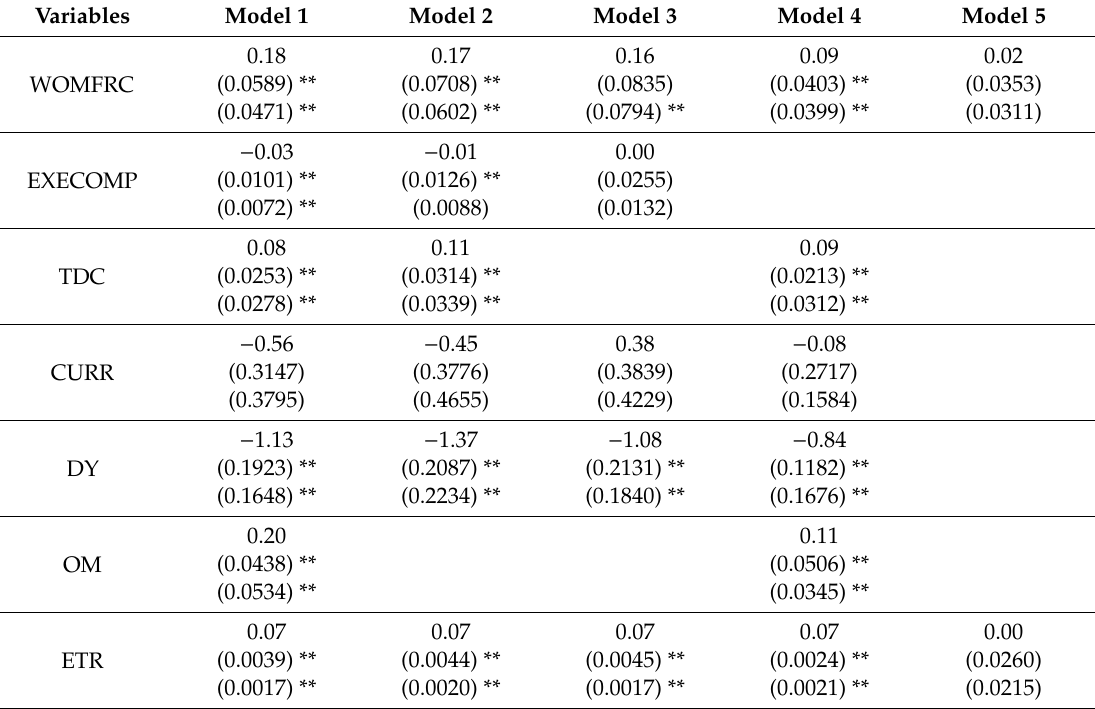
Table 9. The outcomes of panel data pooled regression models regarding the influence of water, waste, and energy consumption, alongside firm and corporate governance-specific variables, on price-to-book